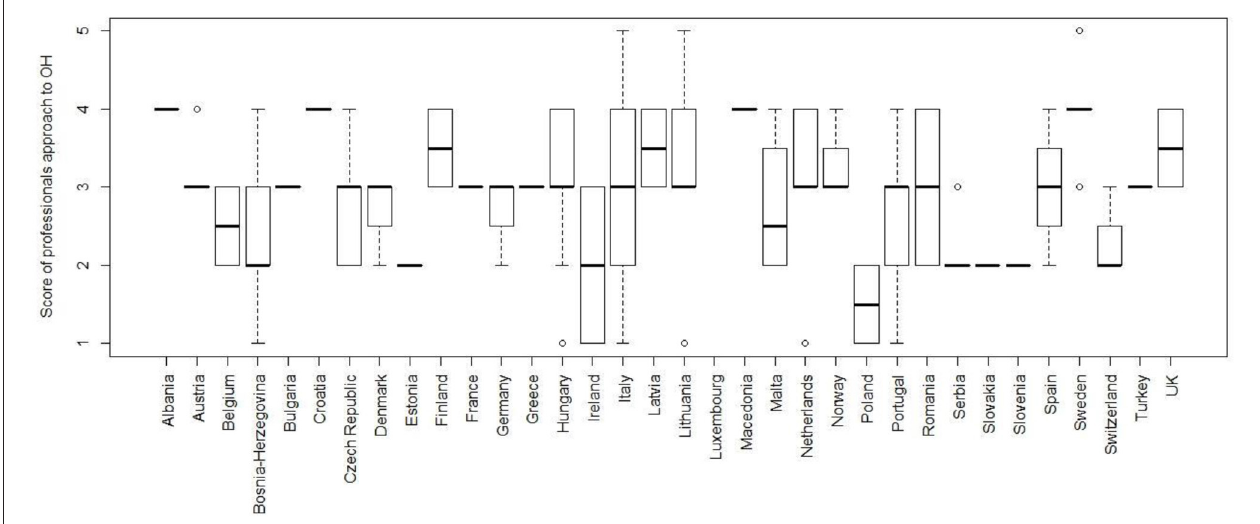
FIGURE 6 | Boxplot of the scores attributed by respondents on the implementation of the OH approach by professionals in their respective countries; scoring from one (poor) to five